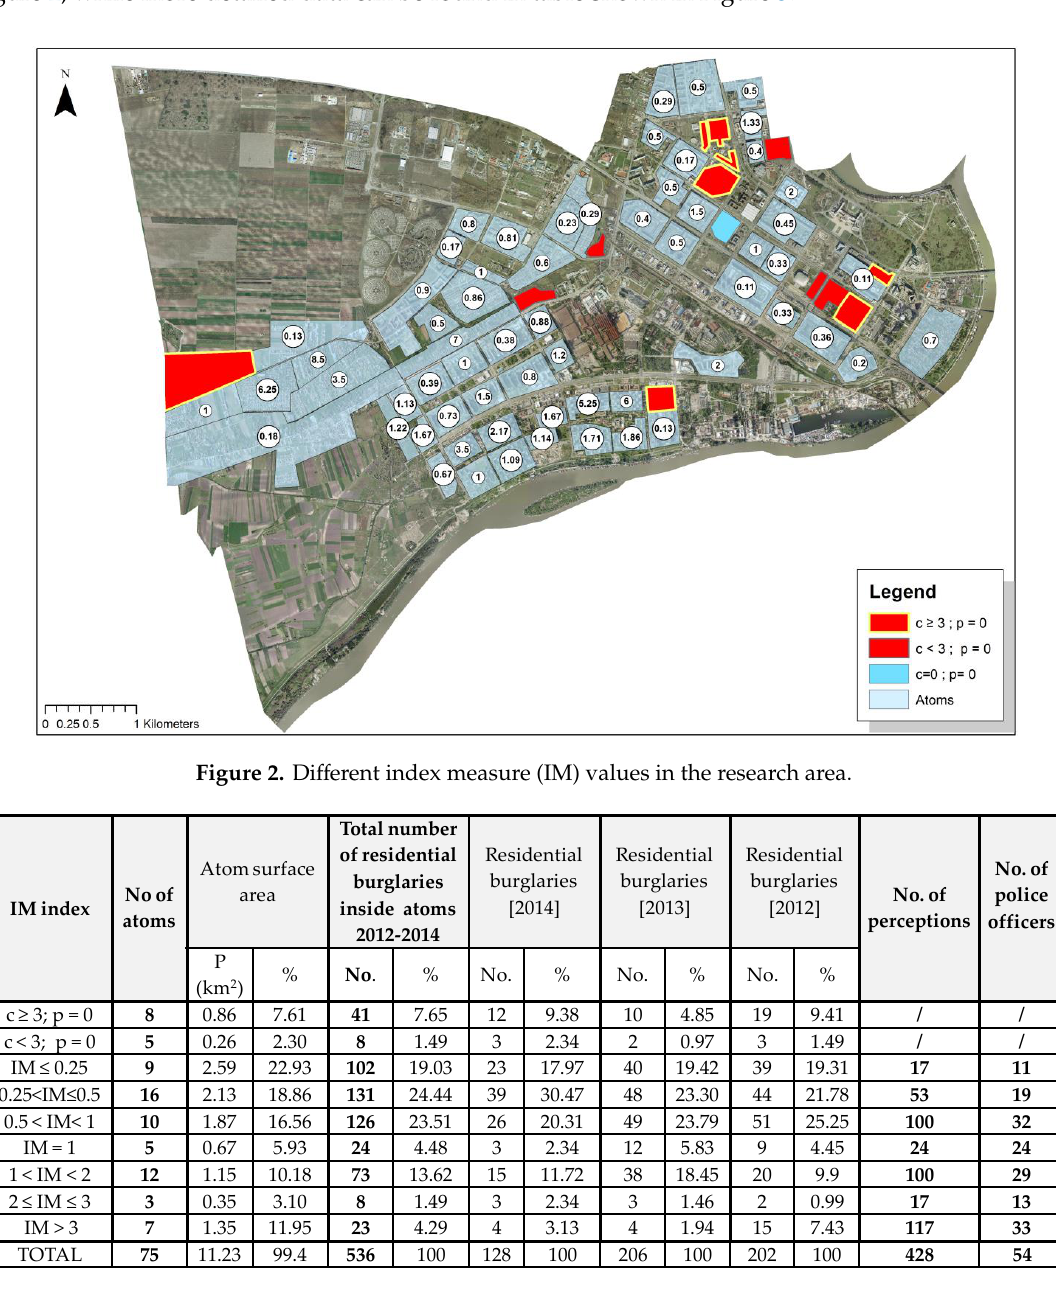
Figure 3. Detailed presentation of research results.